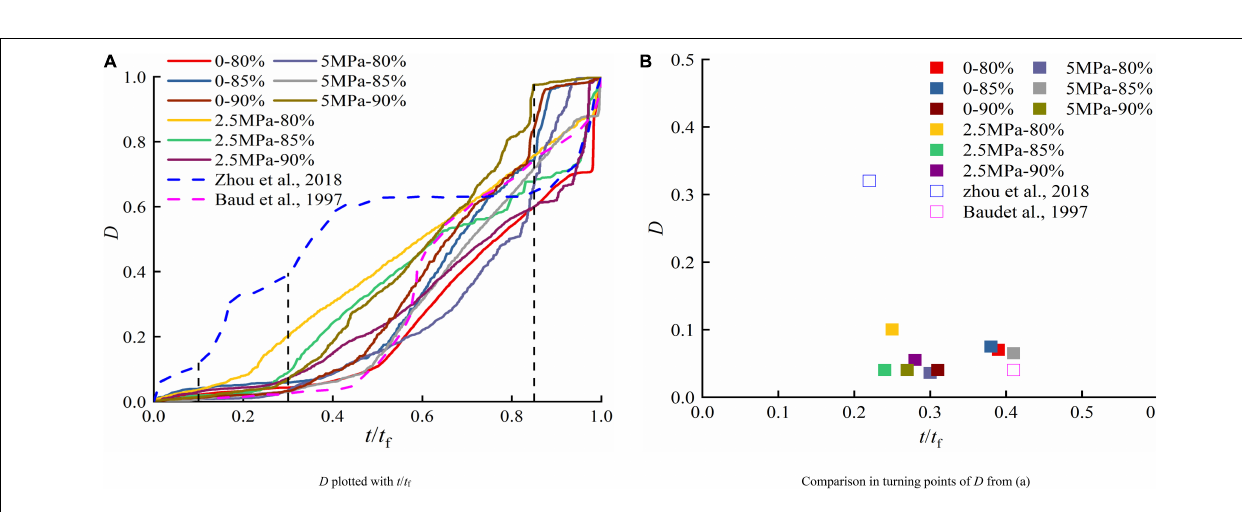
Frontiers in Earth Science |